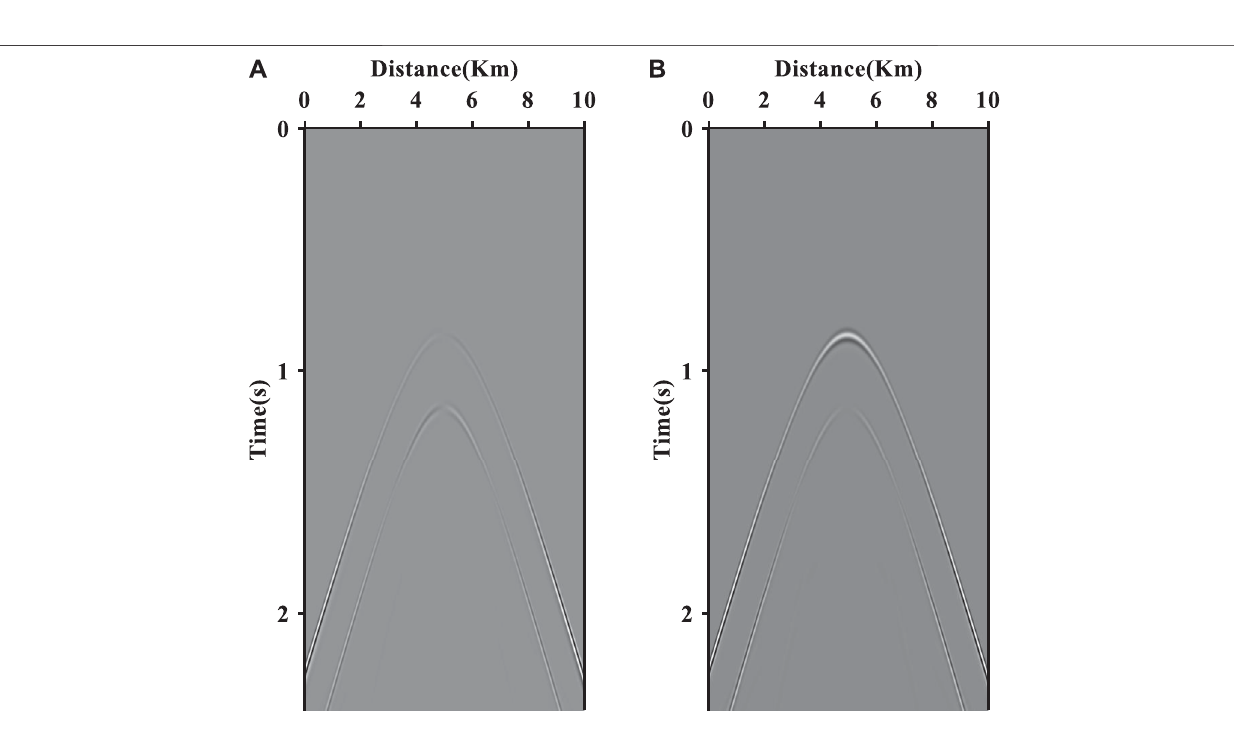
Frontiers in Earth Science |